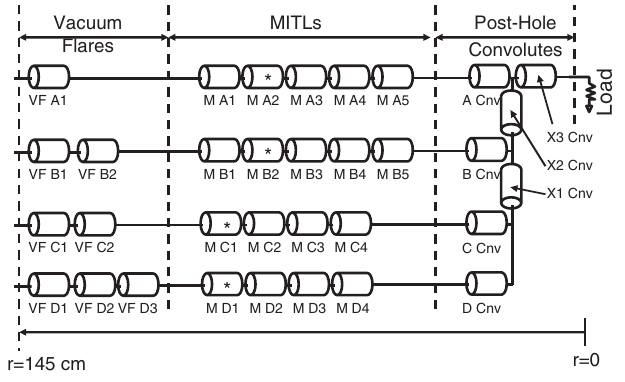
FIG. 3. Schematic of the transmission-line equivalent circuit model used in the LSP simulation to model the ZR accelerator’s vacuum section and load. The starred elements indicate the measurement position for the MITL currents. Values for the various elements are given in Table I.